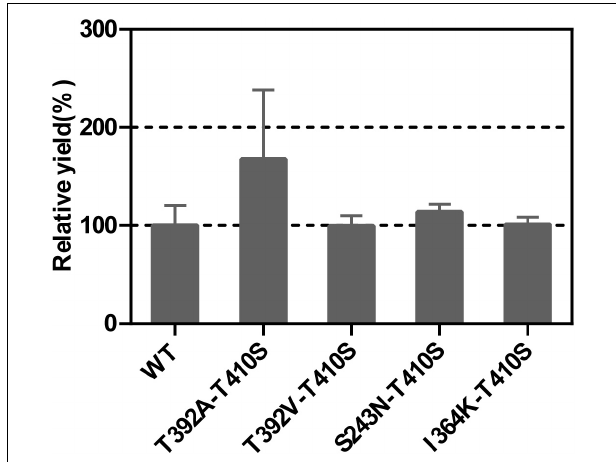
FIGURE 6 | The relative yields of LTC2 double mutants compared with WT.